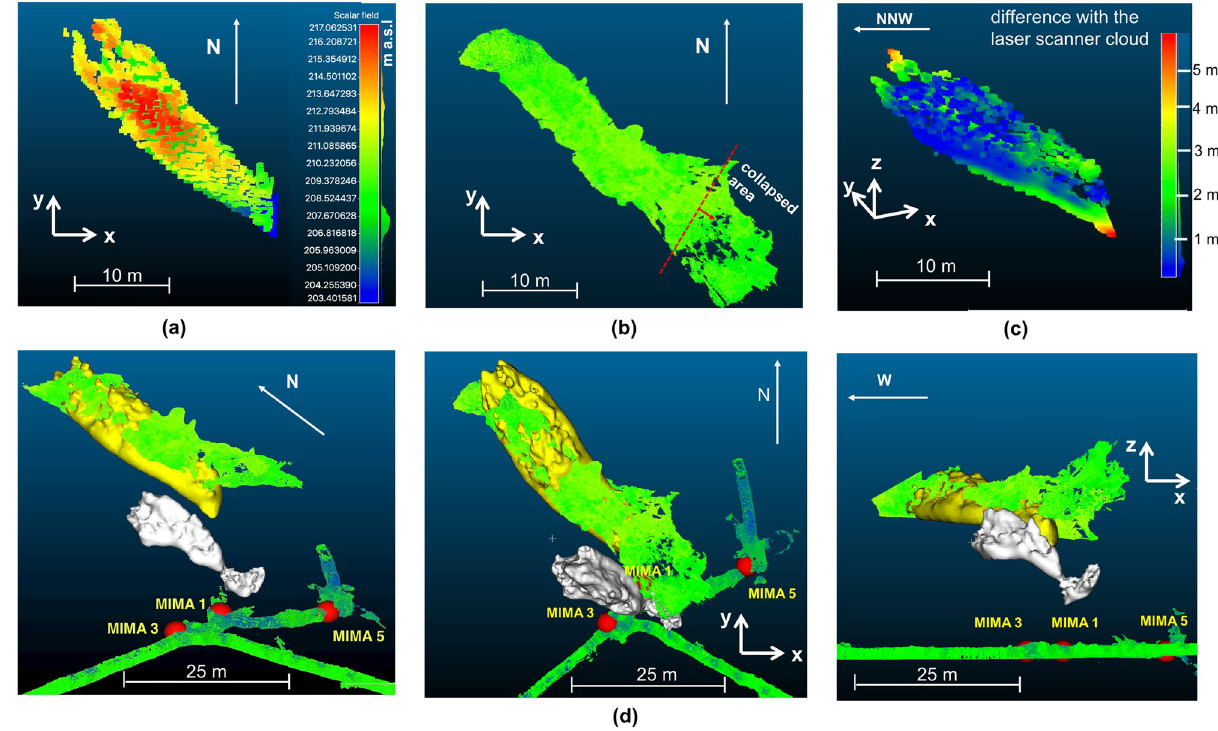
Figure 10. Three-dimensional representation of reconstructed cavities using the back-projection technique. In ( a ) the point clouds relating to the Gran Cava (on the left) reconstructed exclusively with the muographic measurements (in altitude colour’s scale) is shown. In ( b ) the point cloud of the Gran Cava acquired with the laser scanner technique is shown. In ( c ) there’s the difference between the Gran Cava point cloud obtained with the muon radiography technique and that obtained with the laser scanner. The difference was evaluated with the CloudCompare software. In ( d ) the three cavities observed, the laser scanner point cloud of the tourist tunnel, and the three points of MIMA measurement positions (drawn as spheres) are shown with mixed, top and lateral orientations.